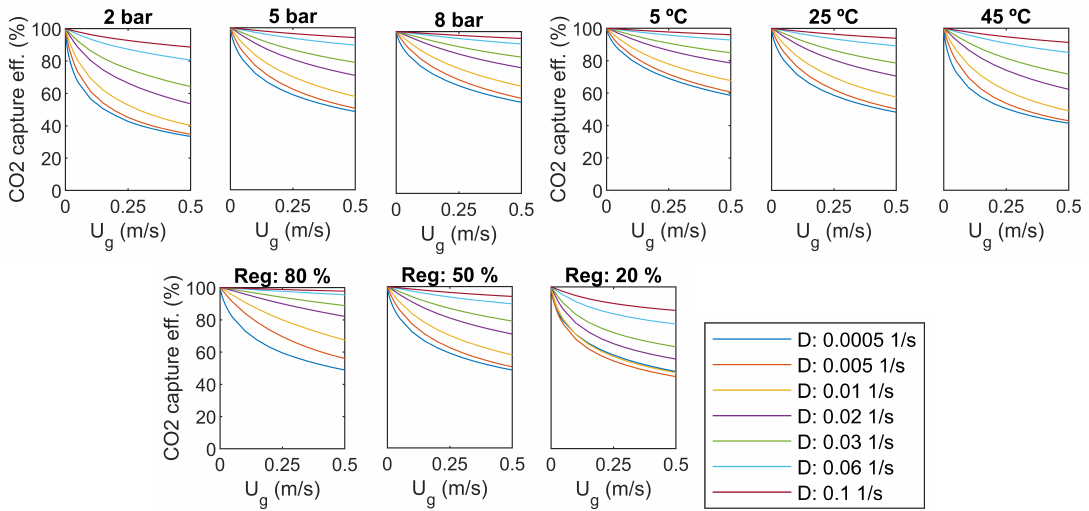
Figure 7. CO 2 capture efficiency, sensitivity to pressure, temperature, and regeneration efficiency.